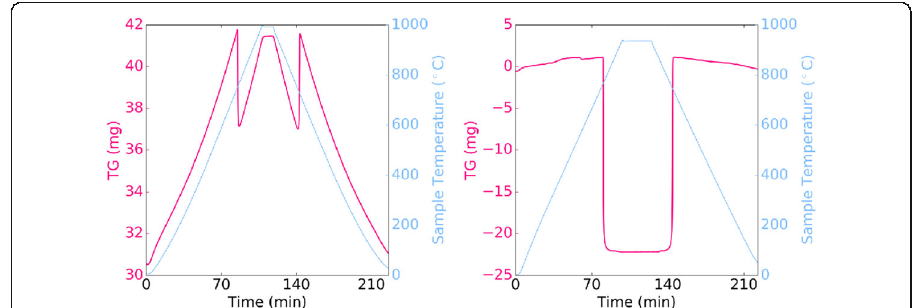
Fig. 3 Left: Initial test on Fe sample proves concept but is full of systematic errors and has small effect size. Right: Same mass of Fe with the new magnet, power supply, and properly set inert gas flow rate. Blue lines are sample temperature profiles on right axis and red lines are the TGA signal on left